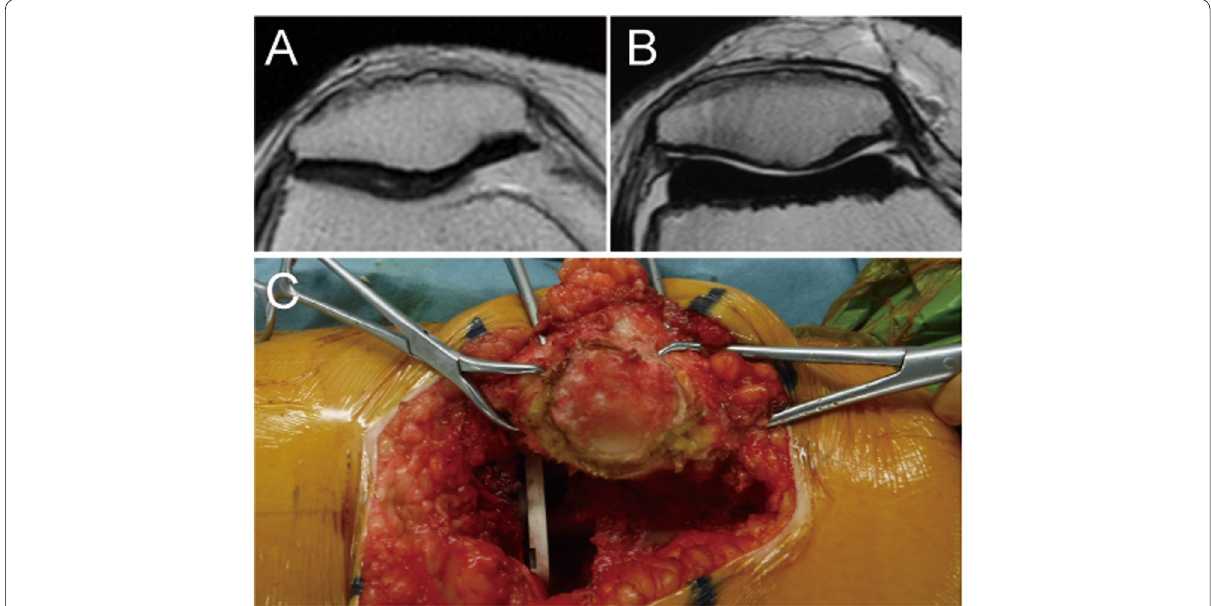
Table 6 Comparisons of the degree of cartilage thickness change in the central, medial, and lateral facets Central facet Medial facet Lateral facet P -value Amount of change in cartilage thickness 1.57(0.63) Data are reported as mean (standard deviation) unless otherwise indicated. Bolded P -values indicate statistical significance ( P < .05) a One-way analysis of variance b Significant difference between groups central and lateral facet, medial and lateral facet (post hoc Tukey–Kramer test)